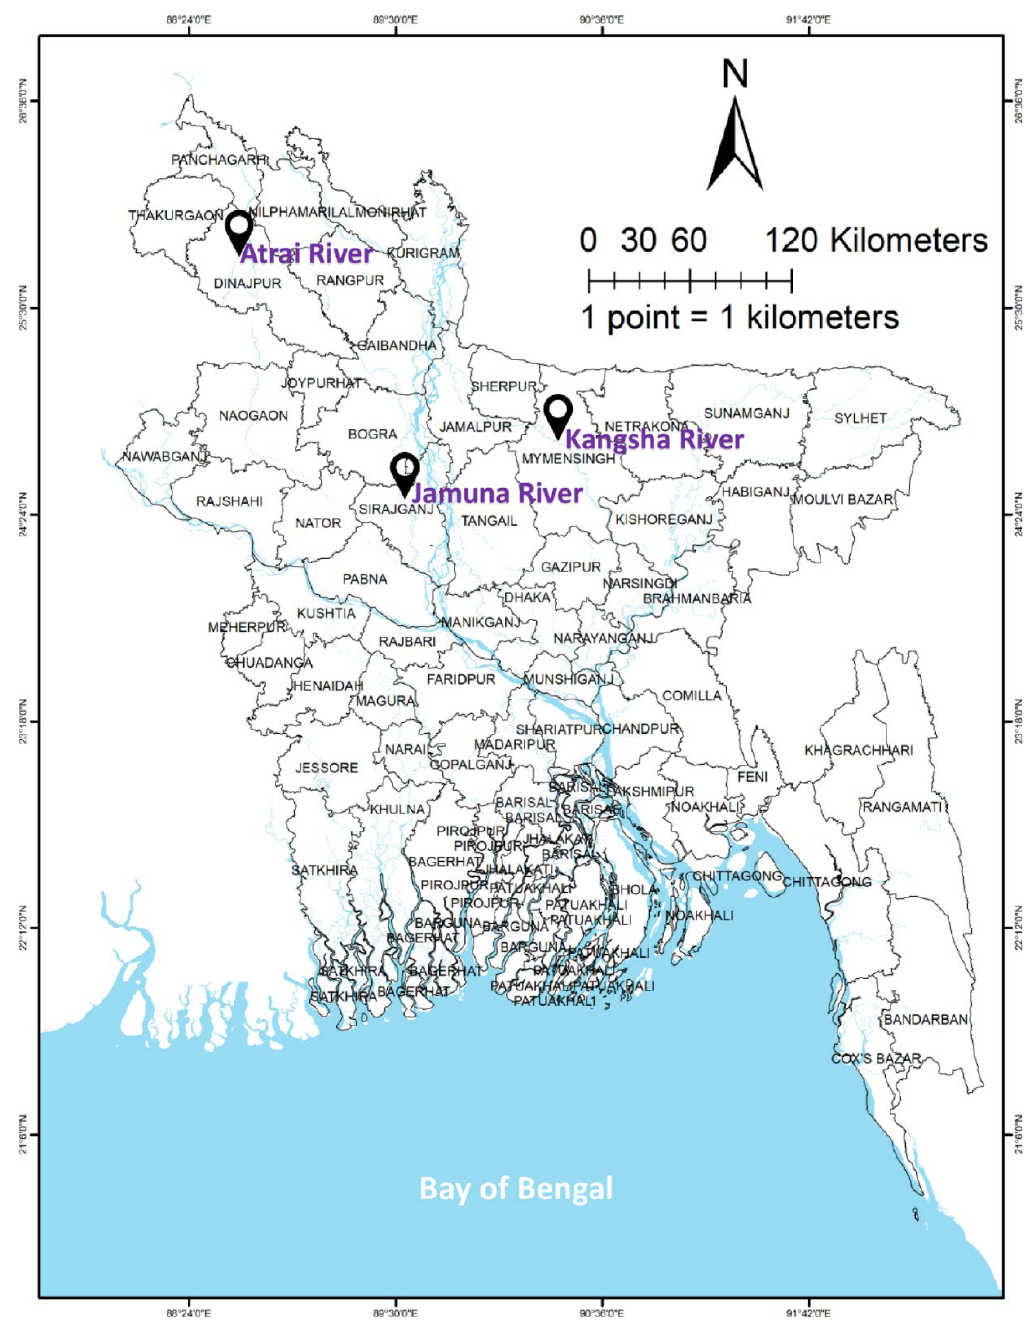
Figure 1. Geographical position of three rivers belonging the Ariza labeo ( L. ariza ) population from where the sample fry was collected.